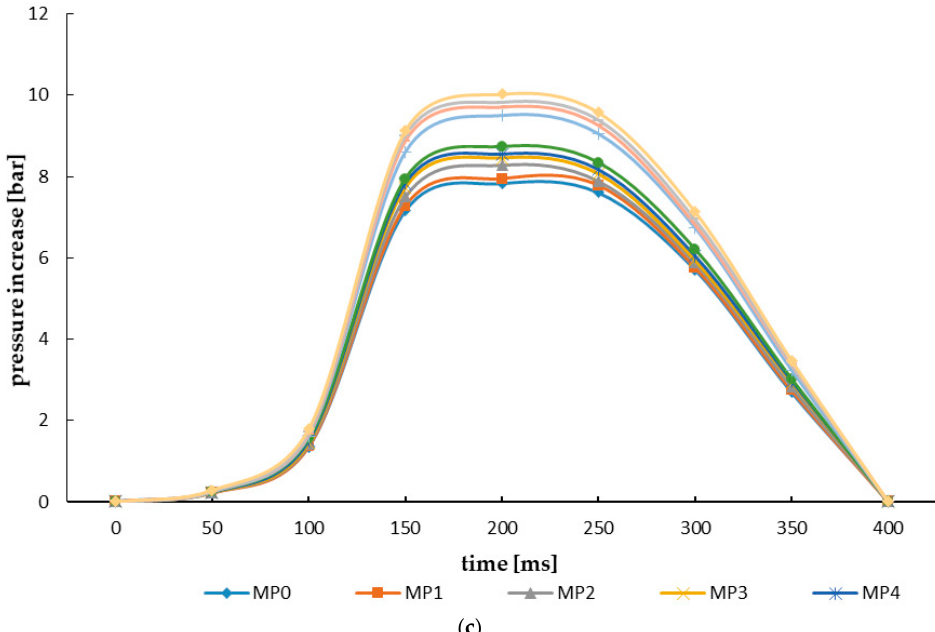
Figure 5. Distribution of dust explosion pressure of pellets and biocarbons produced therefrom: ( a ) oak sawdust material, ( b ) coniferous sawdust material, ( c ) coniferous–deciduous sawdust material.